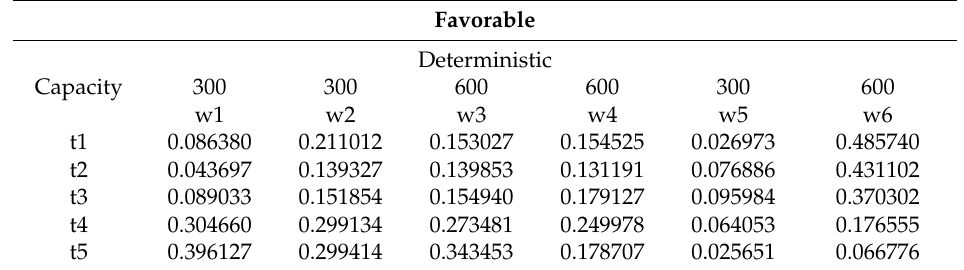
Table A22. w_det_pu_1( t , w ): includes the available wind power for each unit i calculated in per unit values.